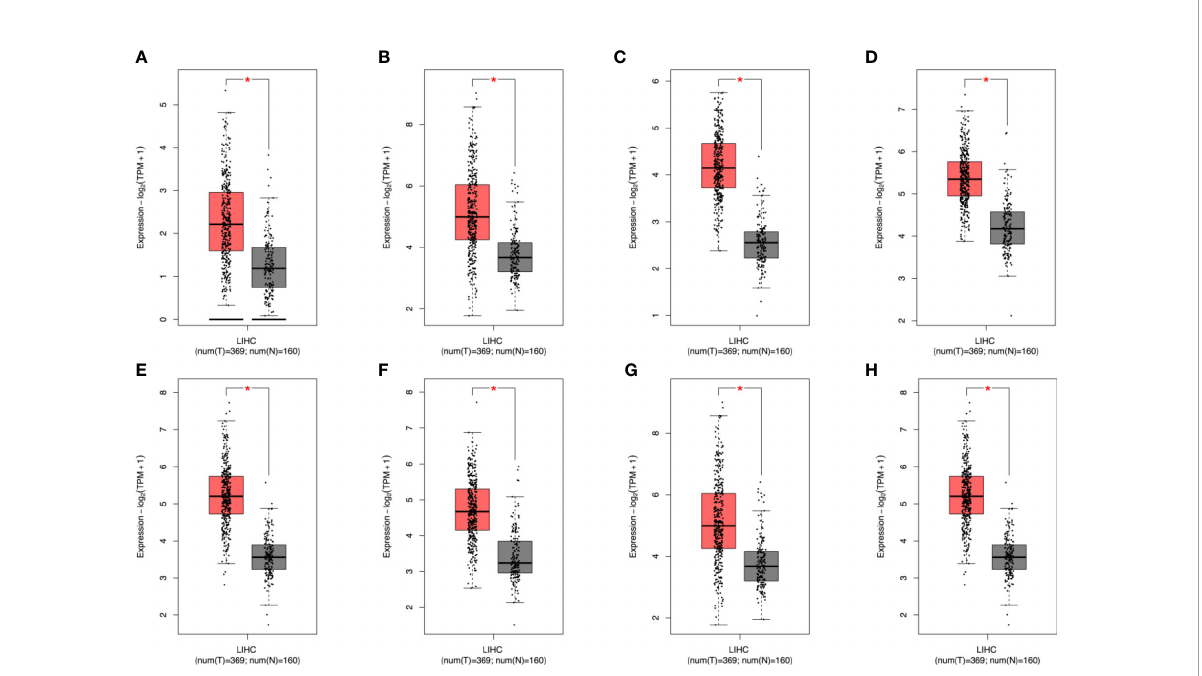
FIGURE 6 TCGA+GTEx and GSE101685 data to further analyze the differential expression of genes. After analysis, it was found that the eight genes veri fi ed above were all differentially expressed. In the fi gure, red represents cancer patients and gray represents normal samples (A – H) EZH2,GRPEL2, PIGU, PPM1G, SF3B4, TXNRD1, NDRG1, TUBG1. * stands for P value <